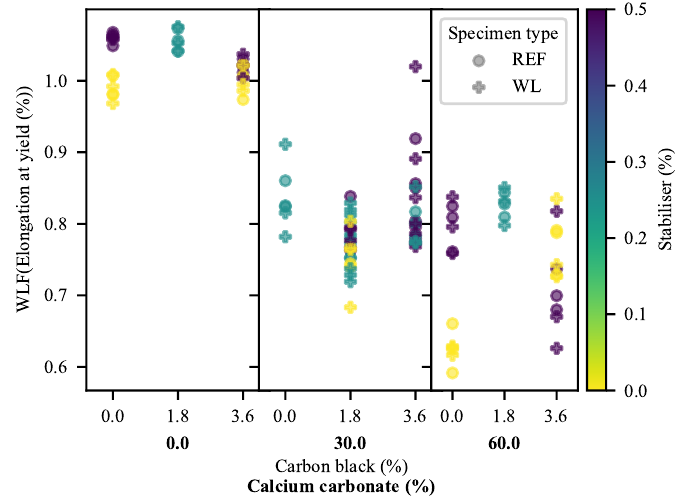
Figure 9. WLF( (cid:101) Y ) as a function of the loadings of calcium carbonate, carbon black and the stabiliser package. Distinct changes in curvature with changing CB can be seen with the steps in CC, as well as the step-down from the 0-CC